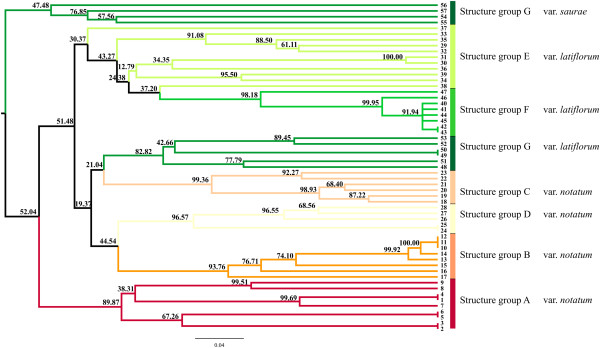
Dendrogram based on Jaccard´s similarity coefficient for 57Paspalum notatumaccessions. An UPGMA dendrogram based on Jaccard´s similarity coefficient for 57 Paspalum notatum accessions. The branch colors correspond to the colors in the STRUCTURE clusters from Figure 4, K=7.